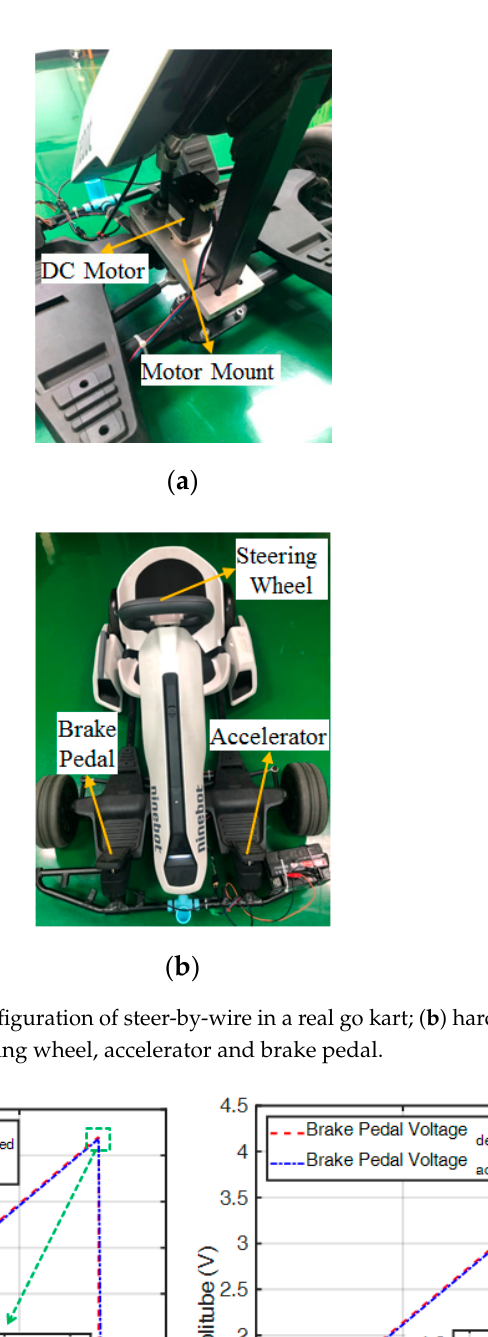
Figure 13. ( a ) Accelerator voltage vs. time for the drive-by-wire; ( b ) brake pedal voltage vs. time for the